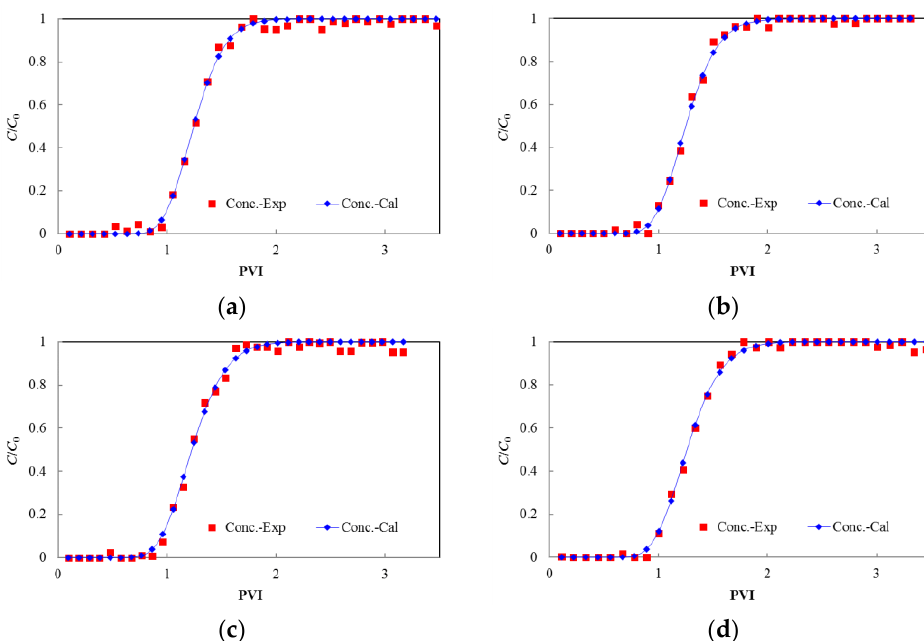
Figure 5. Data fitting for tracer concentration ratio versus pore volume injected (PVI) at high flow rate (0.04 cm 3 /s) in natural cores: ( a ) core No. 1 (1570 mD), ( b ) core No. 2 (610 mD), and ( c ) core No. 3 (230 mD).